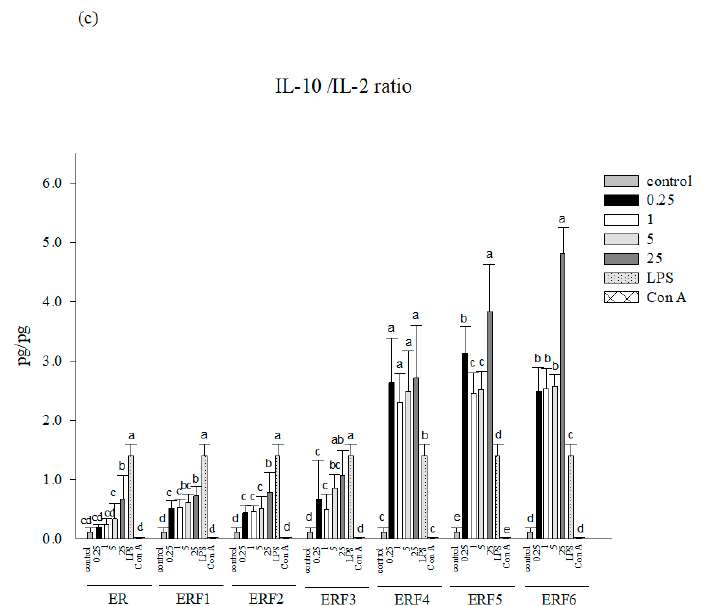
Figure 1. Effect of treatments with different concentrations of steam distilled essential oils of ER, and fractions 1–6 in vitro on IL-2 ( a ), IL-10 ( b ), and IL-10/IL-2 ( c ) cytokine secretions ratios by primary splenocytes from female BALB/c mice. Data are presented as the mean ± SD ( n = 6 biological determinations). Bars in the same plot within the same sample item not sharing a common letter are significantly different ( p < 0.05) from each other assayed by one-way ANOVA, followed by Duncan’s multiple range test. The detection sensitivity of cytokine ELISA kits used in this study was <15.6 pg/mL.